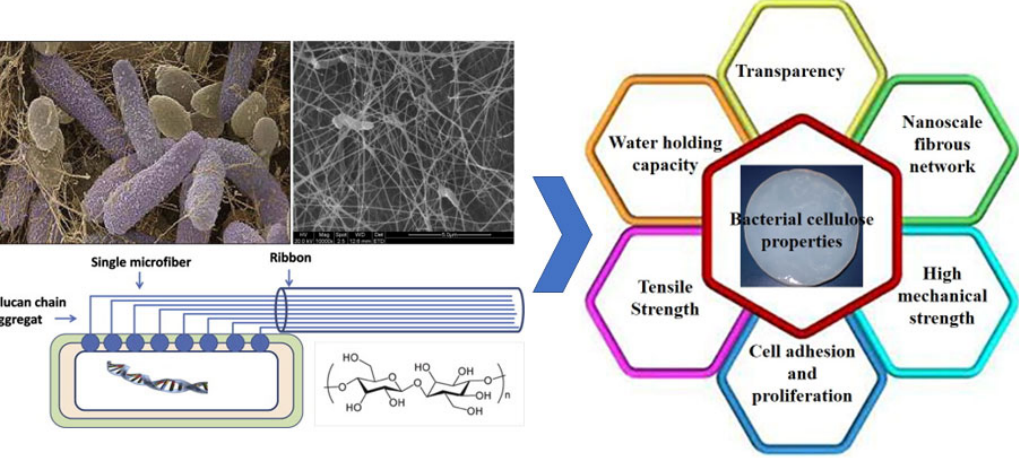
Figure 1. SEM image of bacterial cellulose formed by Acetobacter xylinus and its characteristics. Reprinted with permission from [11]. Copyright (2014), Elsevier .